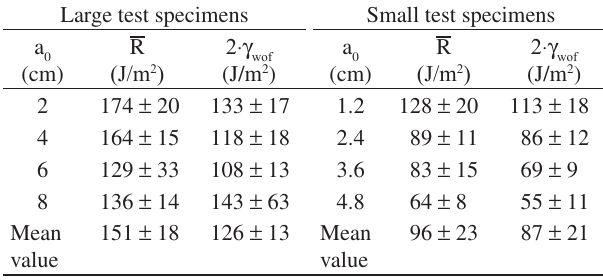
Table 5. Values of R and 2 ⋅γ Large test specimens